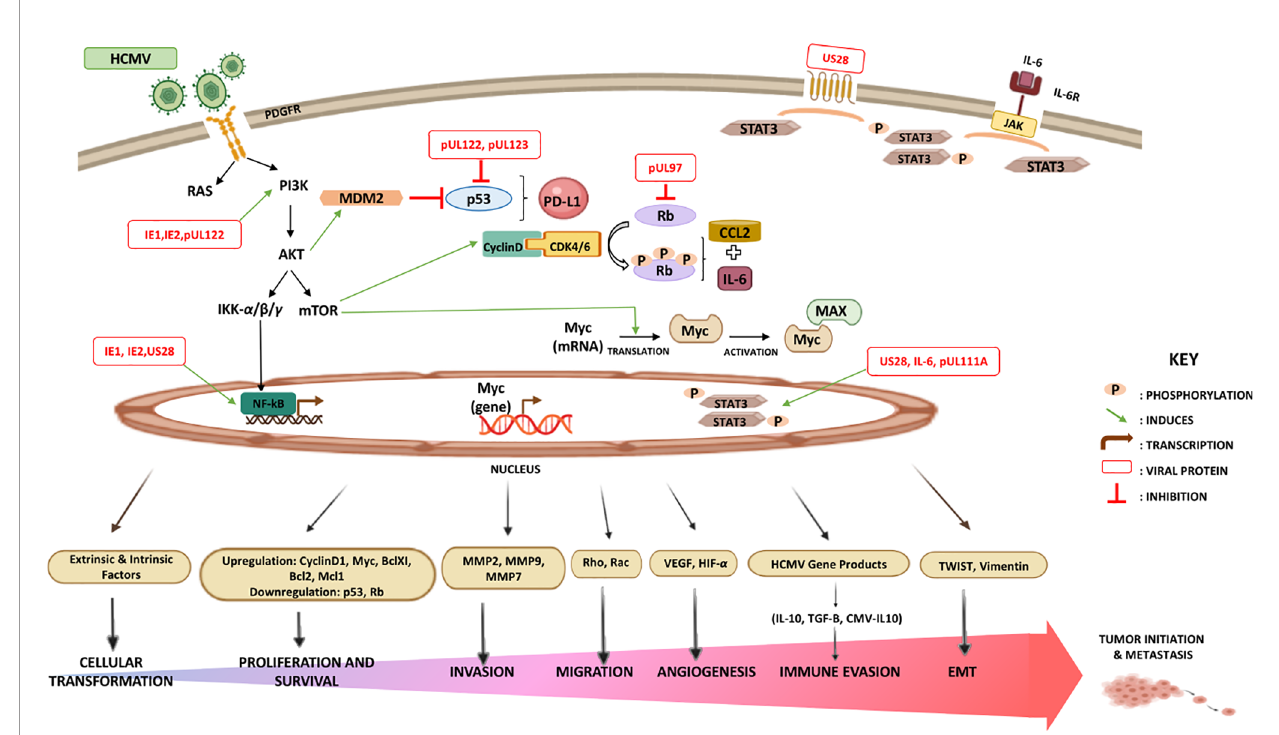
FIGURE 2 | Major signaling pathways stimulated by HCMV that modulate the immune landscape. HCMV-infected cells produce elevated levels of interleukin-6 (IL-6) that activates signal transduction via IL-6 receptor (IL6R)-STAT3 axis. US28, an active chemokine receptor, also plays a major role in activating STAT3 in cancer cells. The combination of STAT3 activation and the impact of HCMV on cancer cell apoptosis, invasion, migration, adhesion, angiogenesis, and immunogenicity signi fi cantly exacerbates malignancy. In contrast to p53 and Rb, the upregulation of Akt, Myc, PD-L1, and CCL2 strongly exerts immunosuppressive and oncomodulatory effects. HCMV-induced alterations in the TME may contribute to